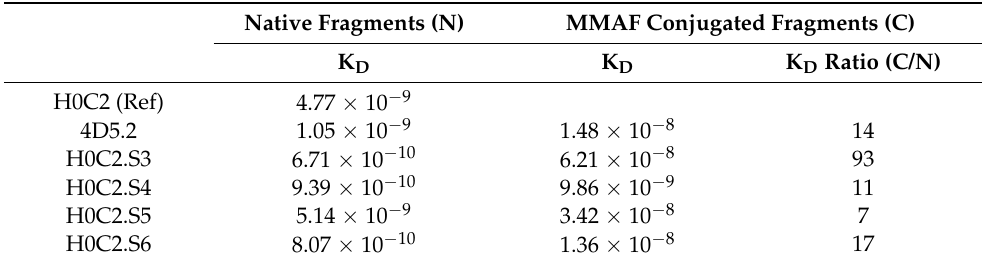
Table 3. Equilibrium dissociation constant K D measuring the binding affinity of the native fragments H0C2, 4D5.2 and H0C2.Sx (x = 3 to 6) or the conjugated fragments 4D5.2-MMAF and H0C2.Sx-MMAF (x = 3 to 6) towards their specific antigen HER2.